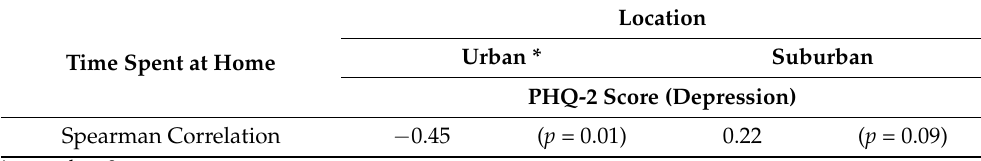
Table 3. Summary statement on the Spearman correlation of participants.